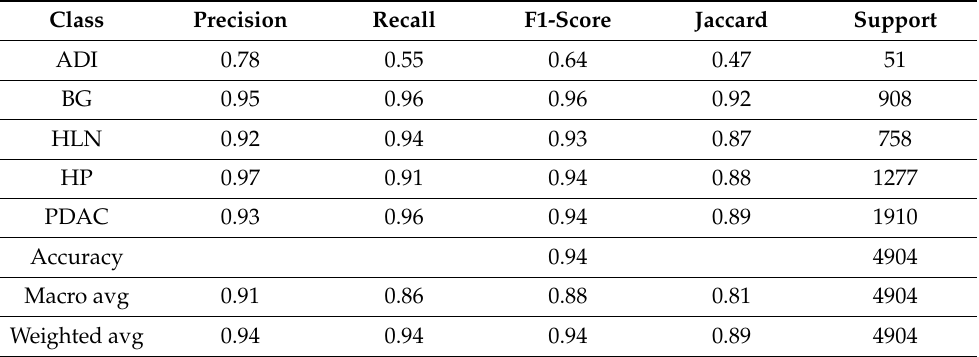
Table 2. Metrics of the cleaned network (ResNet18): Precision, Recall, F1-Score and Jaccard score for the classes healthy pancreas (HP), healthy lymph node (HLN), pancreatic ductal adenocarcinoma (PDAC) and Adipose tissue